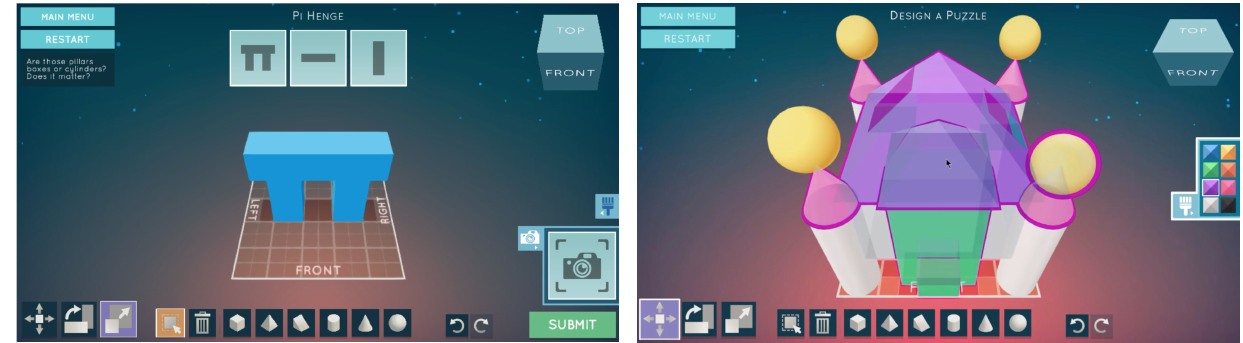
Figure 2. Two gameplay examples in Shadowspect